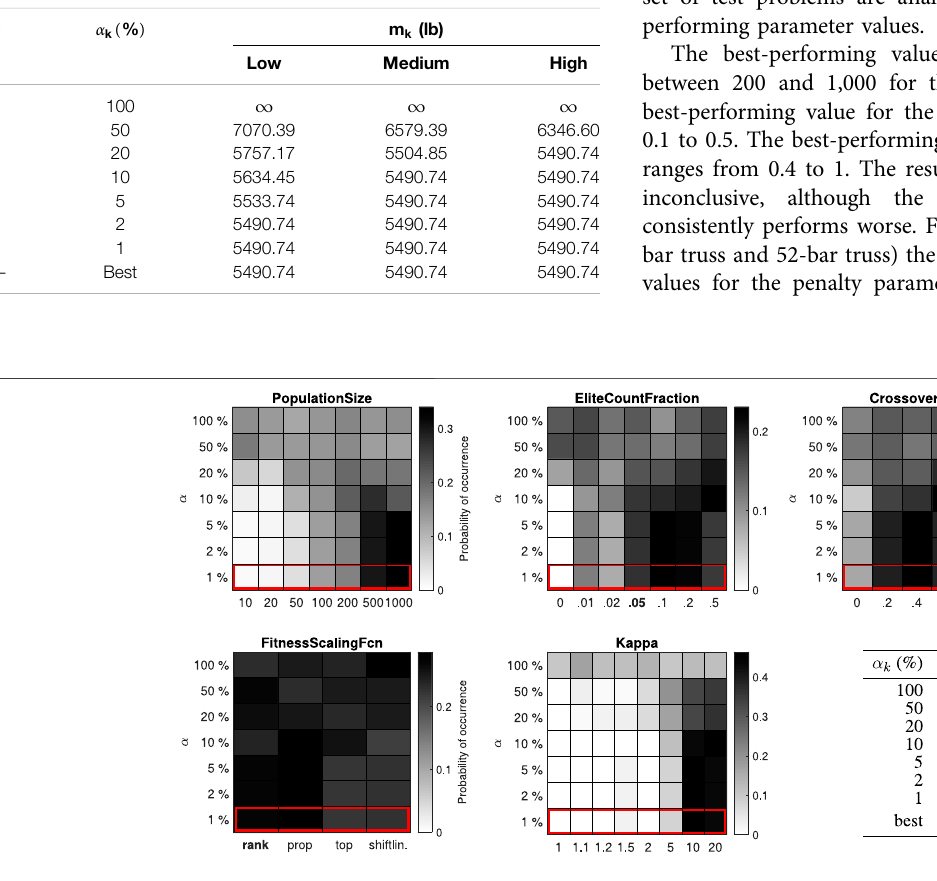
FIGURE 4 | Distribution of control parameter values for the 25-bar truss test problem (8 design variables). The GA is limited to 10 5 function evaluations within a single run. The default value for the PopulationSize is 80, which is not present among the options.